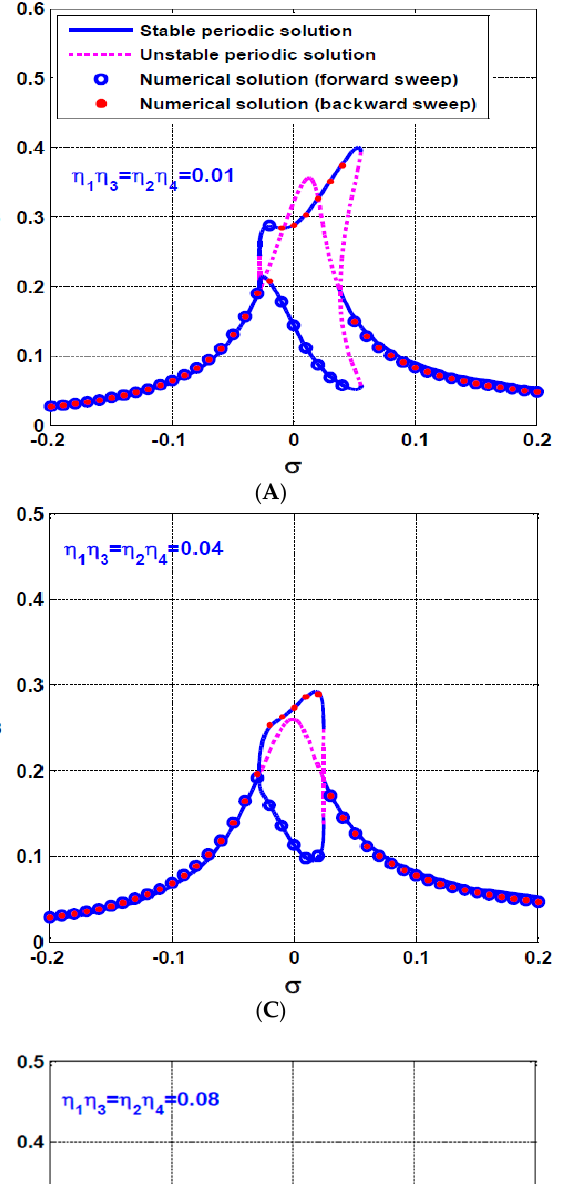
( B ) Figure 15. The rotor system 𝜂 (cid:2869) 𝜂 (cid:2871) = 𝜂 (cid:2870) 𝜂 (cid:2872) — response curve when 𝜎 = 0.0 : ( A ) steady-state oscillation amplitude a in 𝑋— direction, and ( B ) steady-state oscillation amplitude b in 𝑌— direction. It has been concluded before that the coupling of the IRCs to the rotor system modi- fied the rotor linear damping coefficient ( 𝜇 ) to the equivalent damping coefficients 𝜇 (cid:3051) = 𝜇 + (cid:3086) (cid:3117) (cid:3086) (cid:3119) (cid:2870)((cid:3090) (cid:3117)(cid:3118) (cid:2878)(cid:3104) (cid:3118) ) and 𝜇 (cid:3052) = 𝜇 + (cid:3086) (cid:3118) (cid:3086) (cid:3120) (cid:2870)((cid:3090) (cid:3118)(cid:3118) (cid:2878)(cid:3104) (cid:3118) ) . In addition, the detuning parameter ( 𝜎 ) has been mod- ified to 𝜎 (cid:3051) = 𝜎 + (cid:3090) (cid:3117) (cid:3086) (cid:3117) (cid:3086) (cid:3119) (cid:2870)(cid:3104)((cid:3090) (cid:3117)(cid:3118) (cid:2878)(cid:3104) (cid:3118) ) and 𝜎 (cid:3052) = 𝜎 + (cid:3090) (cid:3118) (cid:3086) (cid:3118) (cid:3086) (cid:3120) (cid:2870)(cid:3104)((cid:3090) (cid:3118)(cid:3118) (cid:2878)(cid:3104) (cid:3118) ) . Accordingly, the influence of internal loop feedback gains ( 𝜆 (cid:2869) and 𝜆 (cid:2870) ) of the IRCs on the oscillation amplitudes ( 𝑎 & 𝑏 ) is illus- trated in Figure 16, where Figure 16A,B show the rotor system oscillation amplitudes at 𝜆 (cid:2869) = 𝜆 (cid:2870) = 0.1, 1.0 when 𝜂 (cid:2869) 𝜂 (cid:2871) = 𝜂 (cid:2870) 𝜂 (cid:2872) = 0.08 . It is clear from Figure 16A,B that the rotor system vibration amplitudes ( 𝑎 and 𝑏) when 𝜆 (cid:2869) = 𝜆 (cid:2870) = 0.1 is smaller than its oscilla- tion amplitudes when 𝜆 (cid:2869) = 𝜆 (cid:2870) = 1.0 . It is worthy to mention that the obtained results in Figure 16A,B agree with the derived equations of the equivalent linear damping coeffi- cients 𝜇 (cid:3051) and 𝜇 (cid:3052) , where 𝜇 (cid:3051) and 𝜇 (cid:3052) inversely proportional to 2𝜆 (cid:2869)(cid:2870) and to 2𝜆 (cid:2870)(cid:2870) , respec- tively. Moreover, Figure 16A,B indicate that internal loop feedback gains ( 𝜆 (cid:2869) and 𝜆 (cid:2870) ) play an important role in shifting the system 𝜎 − response curve to the right or the left via